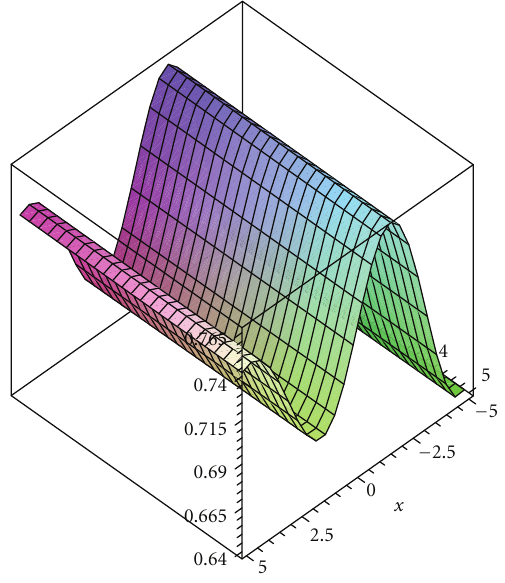
Figure2:Graphof (36)for 𝛼 = 1/2 , 𝑎 6 = 𝑔 0 = 𝑔 2 = 1 , 𝑔 1 = 𝑔 3 = −1 , = sin 𝑥 𝑔 4